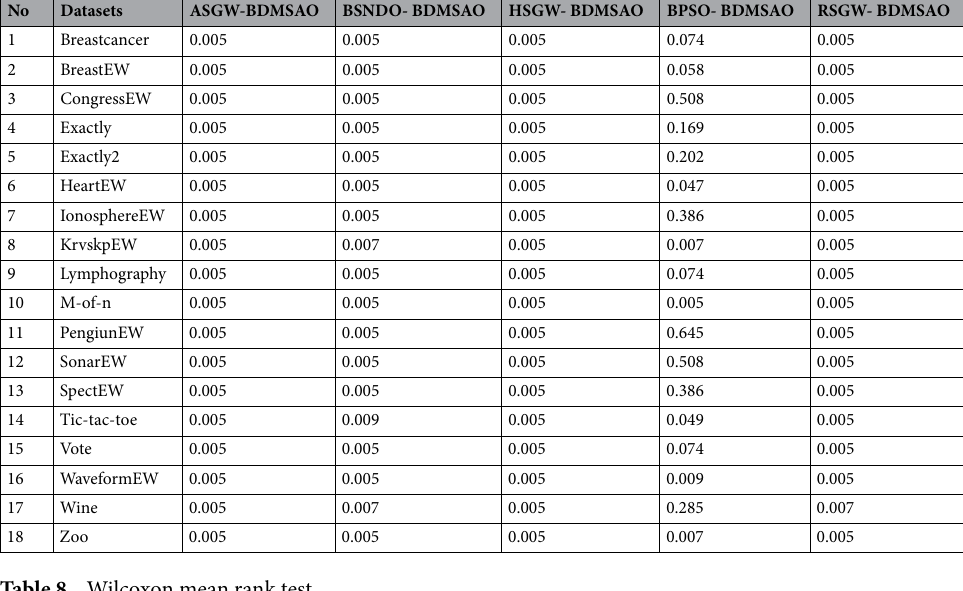
Table 8. Wilcoxon mean rank test.